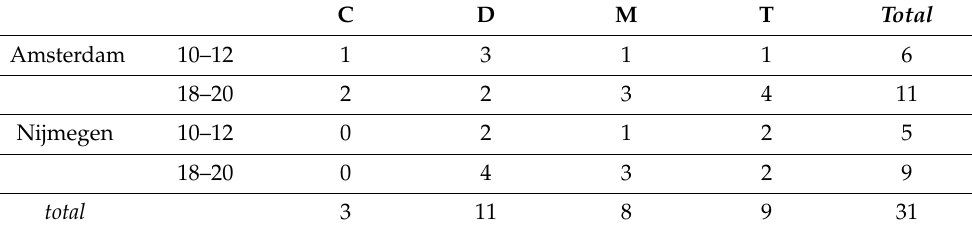
Table 6. No substitute pronoun for a missing R-pronoun; number of addressees per subgroup. C D M T Total Amsterdam 10–12 1 3